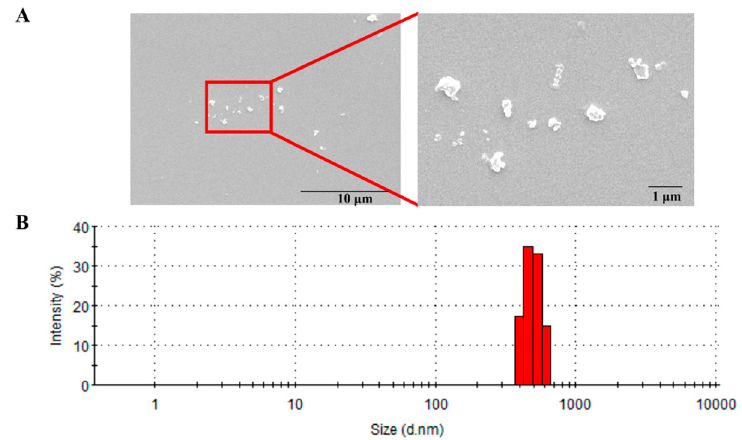
Figure 1. Particulate matter (PM 2.5) size distribution. ( A ) Scanning electron microscope (SEM) image of PM 2.5 (magnification: 5000 × –10,000 × ). ( B ) PM 2.5 size distribution in ultra-pure deionized water was detected by dynamic light scattering (DLS). Table 1. Chemical composition analysis of the PM 2.5